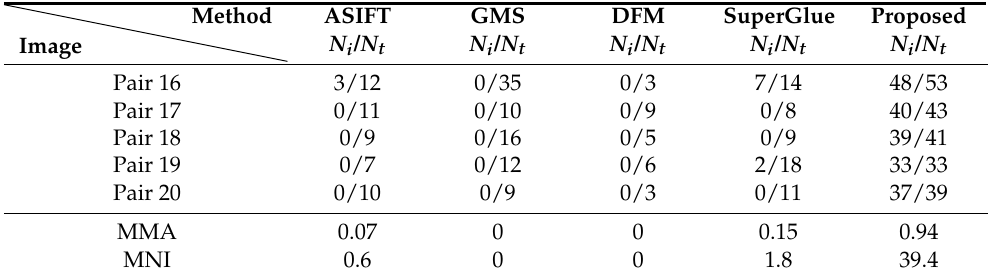
Table 5. Quantitative results of the different methods on dataset SDUST-HOSP.